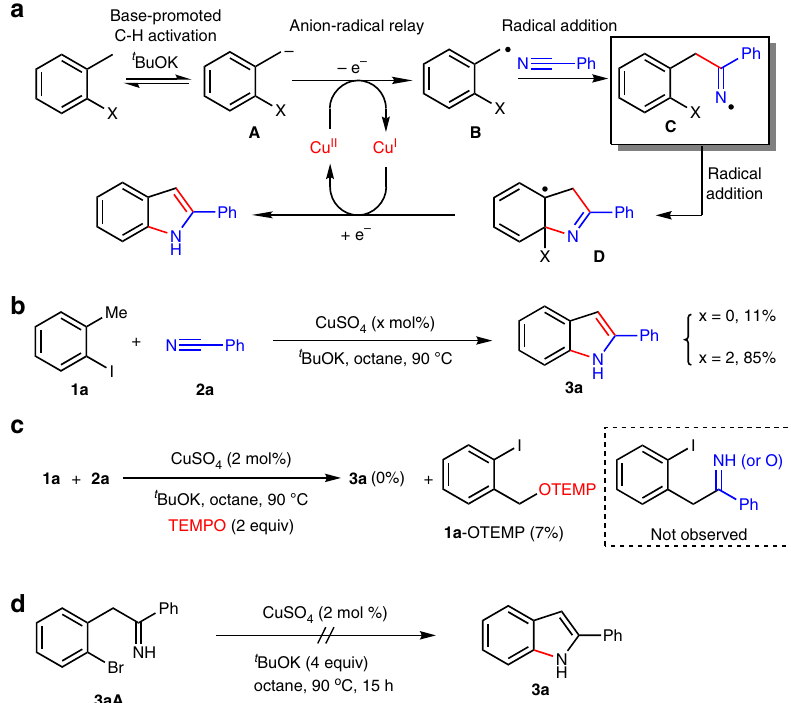
Fig. 2 Iminyl radical from anion-radical redox relay. a Pathway for the copper-catalyzed anion-radical redox relay. b The anion-radical redox relay of 1a and 2a in the presence of 2 mol% CuSO 4 affords 85% of 3a . c TEMPO inhibits the anion-radical redox was con fi rmed by the observation of 1a -OTEMP adduct. d No Ullmann-type intramolecular cyclization was